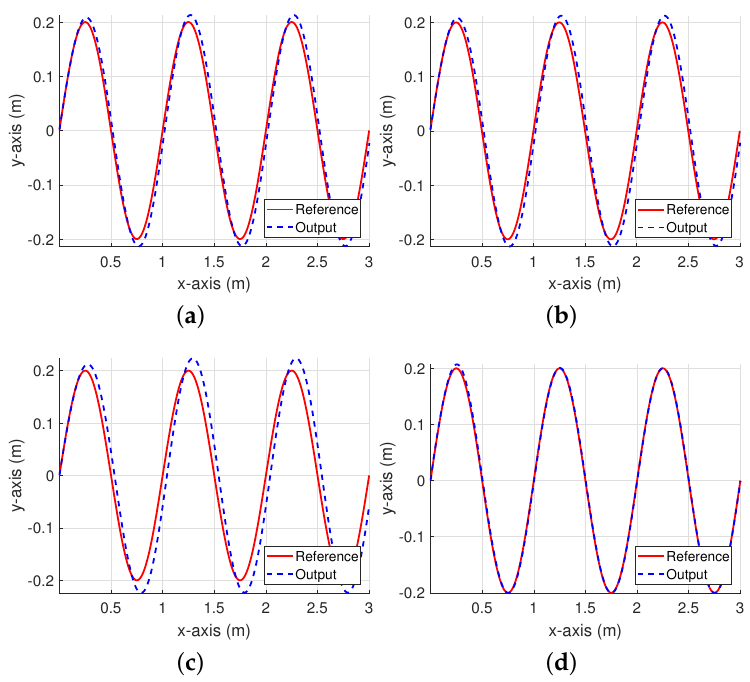
Figure 9. Trajectory following results for the sinusoidal trajectory. ( a ) Trajectory following for PID. ( b ) Trajectory following for BP-PIDNN. ( c ) Trajectory following for HR-PIDNN. ( d ) Trajectory following for EKF-SNPID.